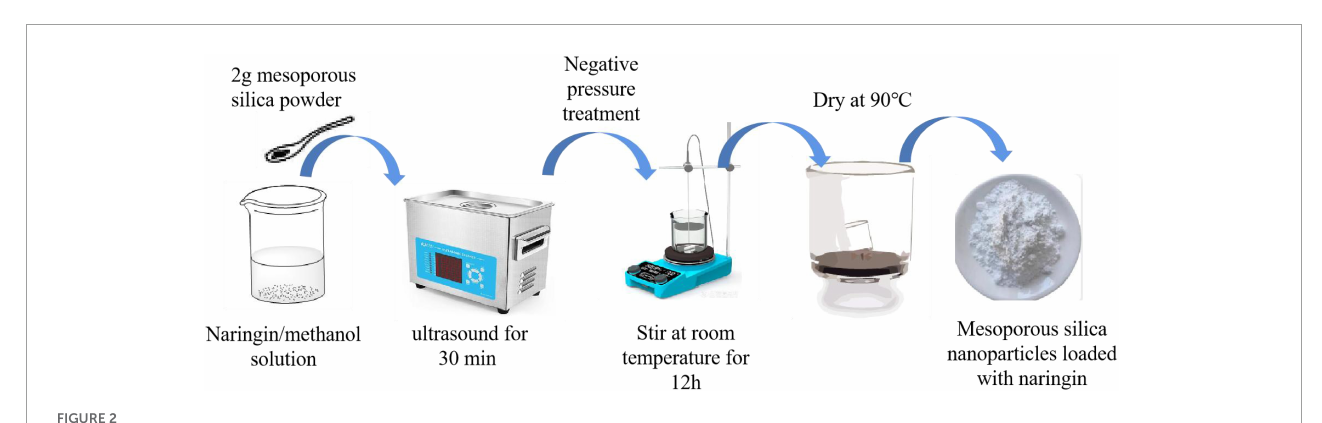
FIGURE2 Preparation of MSN/NG